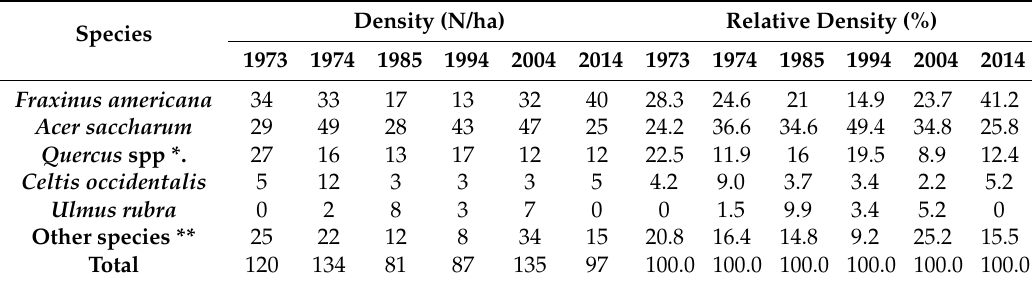
Table 1. Density (N/ha) and Relative Density for the dominant tree species in the canopy (diameter at breast height (DBH) ≥ 30.0 cm) stratum at Dinsmore Woods recorded in the six sampling periods. Species